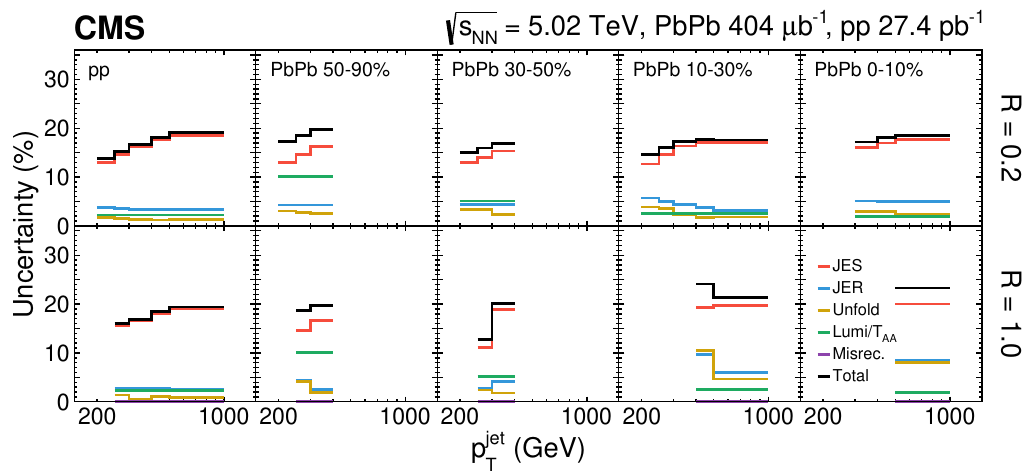
Figure 4 . Relative systematic uncertainties for the spectra of anti- k collisions (left), and PbPb with centrality classes 50–90%, 30–50%, 10–30%, and 0–10% (rightmost plot). The upper plots are for jets with R = 0 . 2 and the lower plots for jets with R = 1 . 0